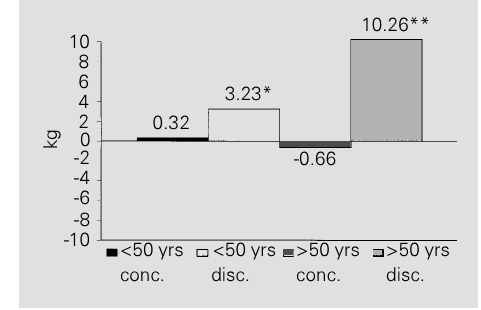
10.26**Figure 2 - Weight excess (actual weight minus ideal weight)